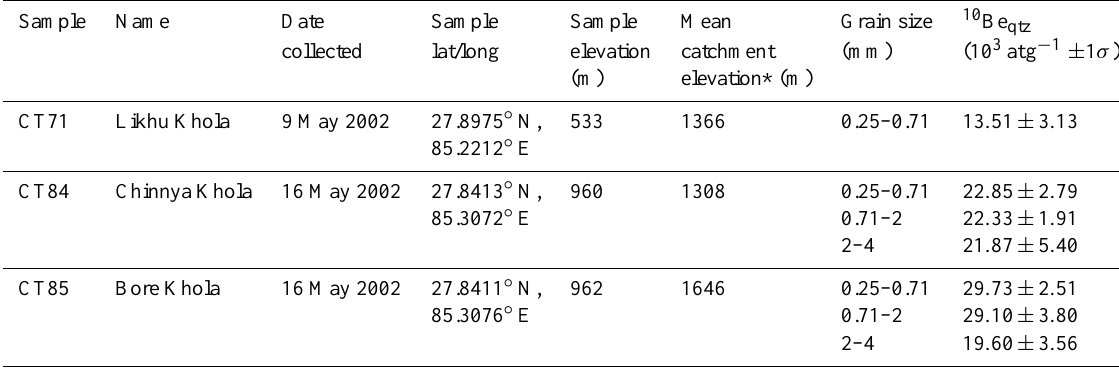
Table 2. 10 Be qtz in river sediment from the Likhu Khola Basin in the Nepal Middle Hills. Sample